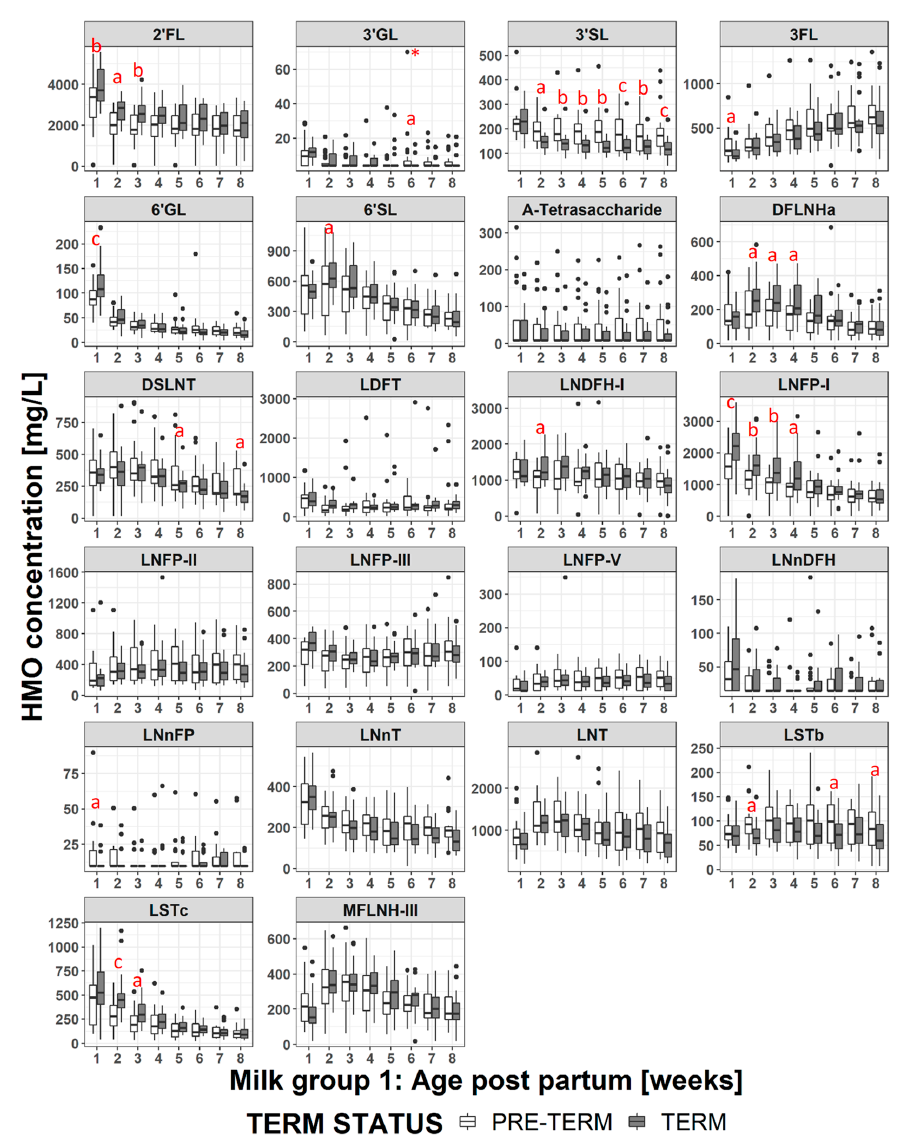
Figure 4. Comparison of HMO concentrations in group 1 term (grey bars) and preterm (white bars) milk. a: p < 0.05, b: p < 0.005 c: p < 0.0005.